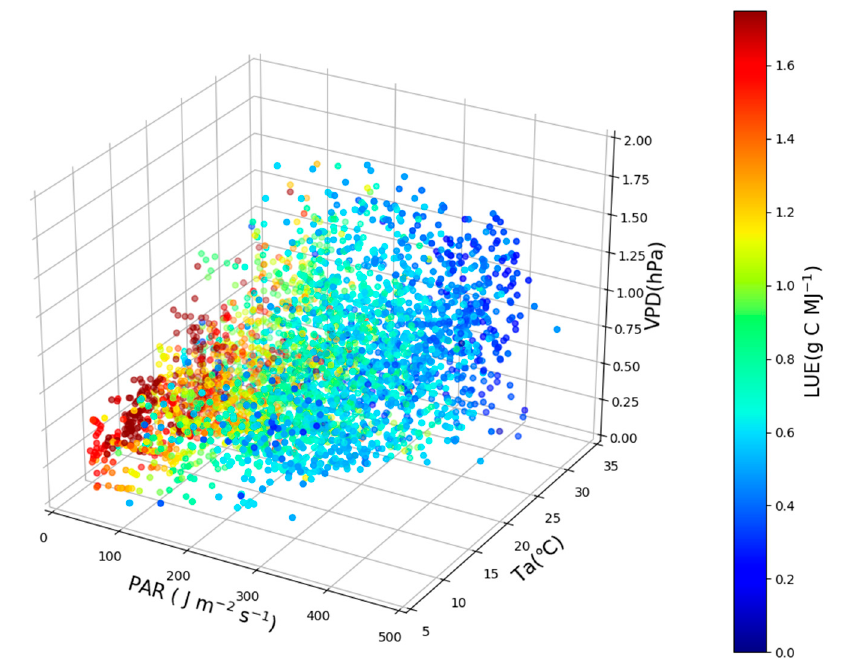
Figure 8. Relationship between Ta, VPD, PAR, and EC-based LUE. Multiple points show identical values that are placed overlapping each other.